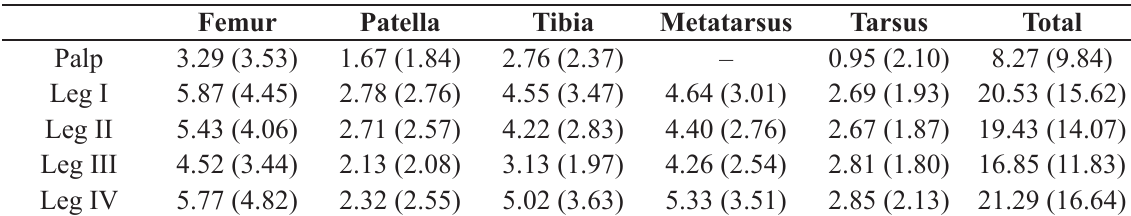
l egs . Tibia and metatarsus I as shown in Fig. 119. Scopula: distal on metatarsi I–II, entire on tarsi I and II, divided on tarsi III, vestigial on tarsi IV. Trichobothria: 2 rows of 8 each on tibiae, 12–14 on